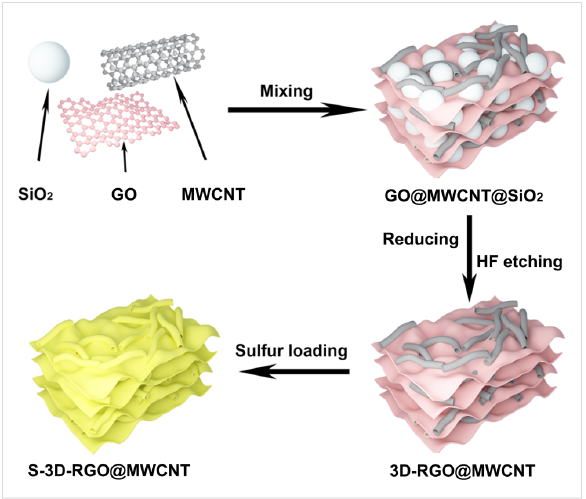
Figure 1: Synthesis of